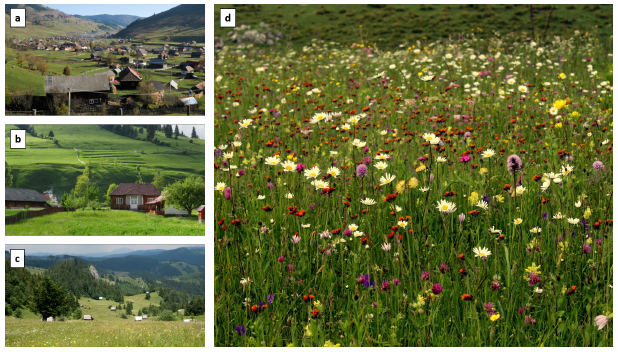
Fig. 2 . (a) The studied settlement: Valea Rece in the valley bottom, along the stream. The houses in the settlement are scattered, arable fields and inner hay meadows can be found among the houses. Photo: Dániel Babai. (b) Inner hay meadows in the valley bottom and on the foothills around the settlement are manured and more intensively used than outer hay meadows. Abandoned arable fields are on the slopes. Photo: Dániel Babai. (c) Extensively managed, extremely species-rich mountain hay meadows (outer hay meadows) are mown once a year, and the hay is stored in small buildings on the hay meadows and transported home only in the winter. Photo: Dániel Babai. (d) An extensively managed outer hay meadow provides habitat for many species in the long term. Photo: András Kelemen.